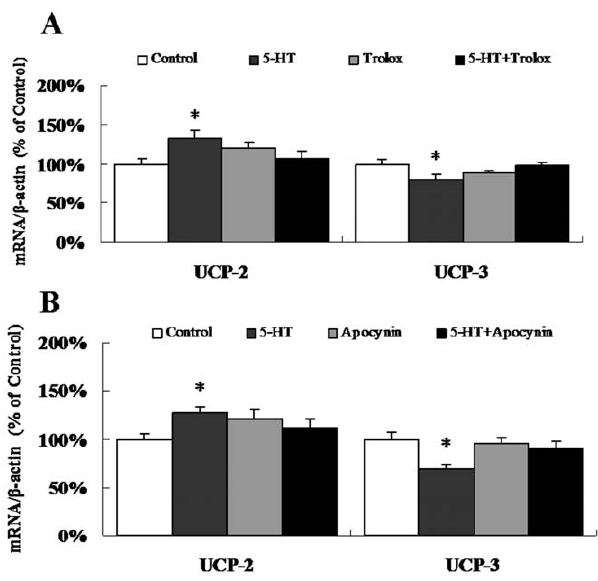
Figure 4. 5-HT has contrasting effects on the expression of UCP-2 and UCP-3 mRNA. Real-time quantitative PCR was used to determine the mRNA levels of UCP-2 and UCP-3. (A) ICV co-injection with 5-HT and Trolox. n=11–12 per group. (B) ICV co-injection with 5- HT and Apocynin. n=8–9 per group. Data are expressed as the means 6 SEM. *, 0.01 , p , 0.05, vs. the control.